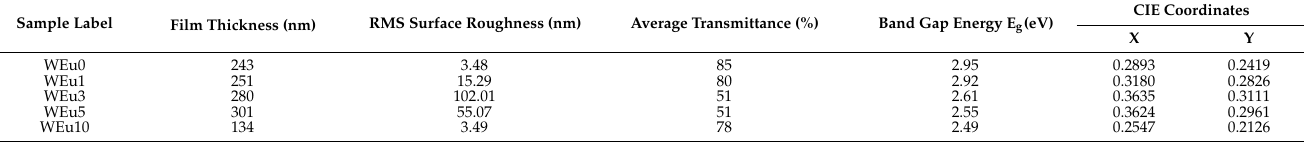
Figure 2. ( a ) Variation in the diffraction angle (2 θ ) (blue dots) and ( b ) inter-planar separation ( d 200 ) (pink pentagrams) of the intense (200) peak as a function of Eu 3+ content. Table 2. Optical and morphological parameters of the un-doped and Eu 3+ -embedded WO 3 films annealed at 600 °C.